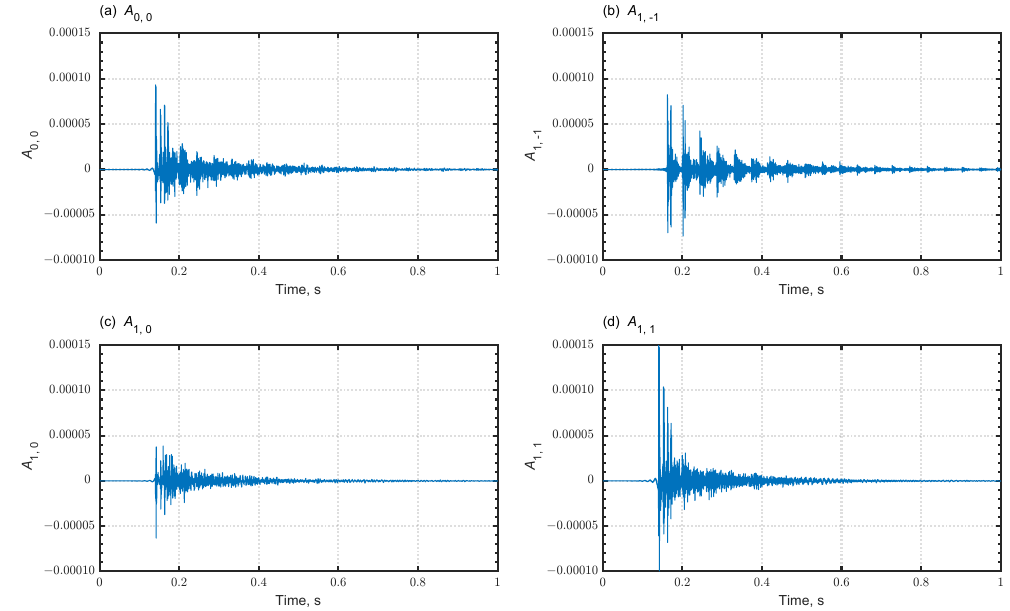
Figure 10. Simulated FOA signals at R3 in Cond. 1: ( a ) A 0,0 ; ( b ) A 1, − 1 ; ( c ) A 1,0 ; and ( d ) A 1,1 . Figure 13a–d show four room-acoustics parameters, the reverberation time (T30), the early decay time (EDT), the A-weighted relative sound pressure level (SPL (A)), and the rapid speech transmission index (RASTI) at six receivers R1 ∼ R6 for Cond. 1 and Cond. 2. Those parameters were evaluated using ODEON 16 room-acoustics simulation